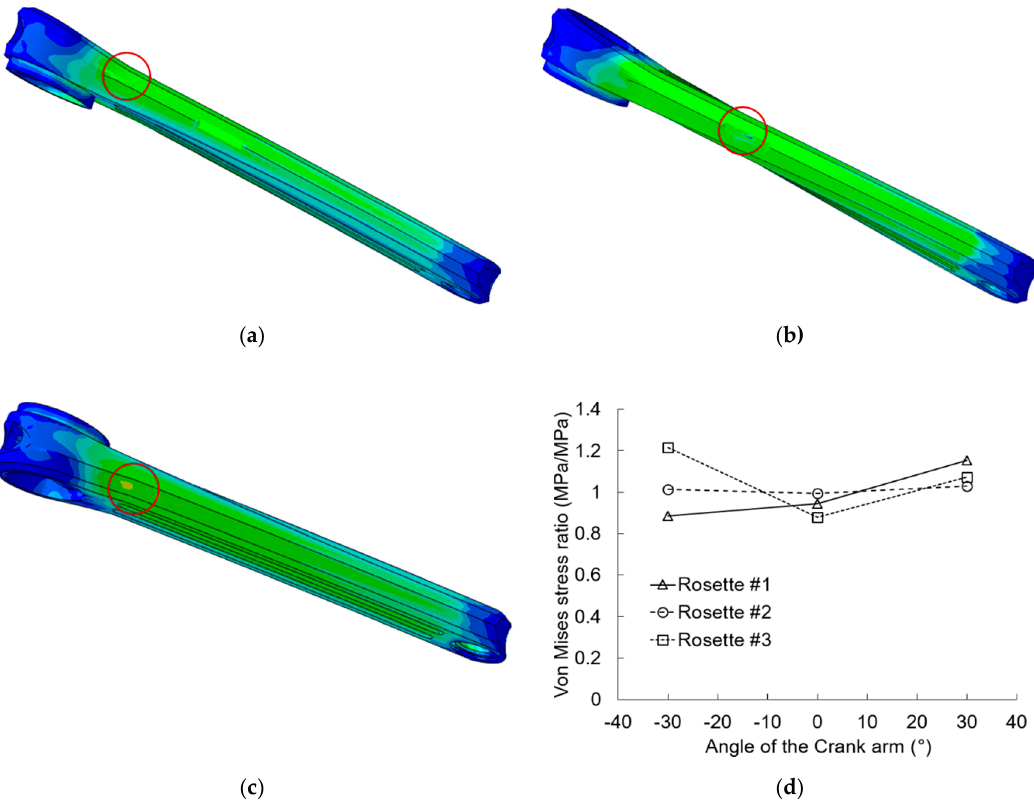
Figure 19. Verification of the stress behaviour of the crank arm for different angle position: ( a ) 30 degree, ( b ) 0 degree and ( c ) − 30 degree and ( d ) ratio stress versus angle of the crank arm.